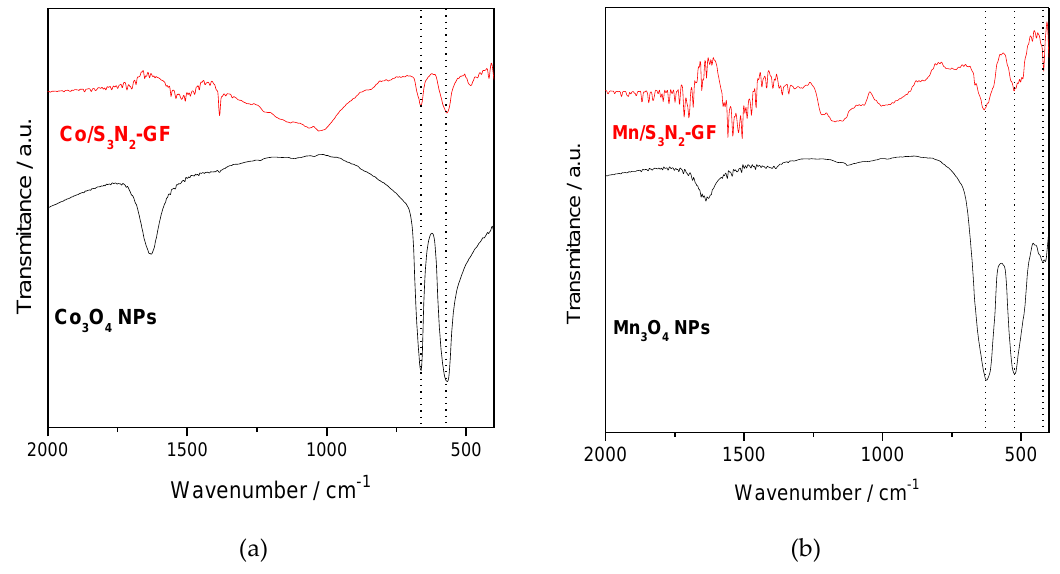
/ S 3 N 2 –GF ( b ) composites.